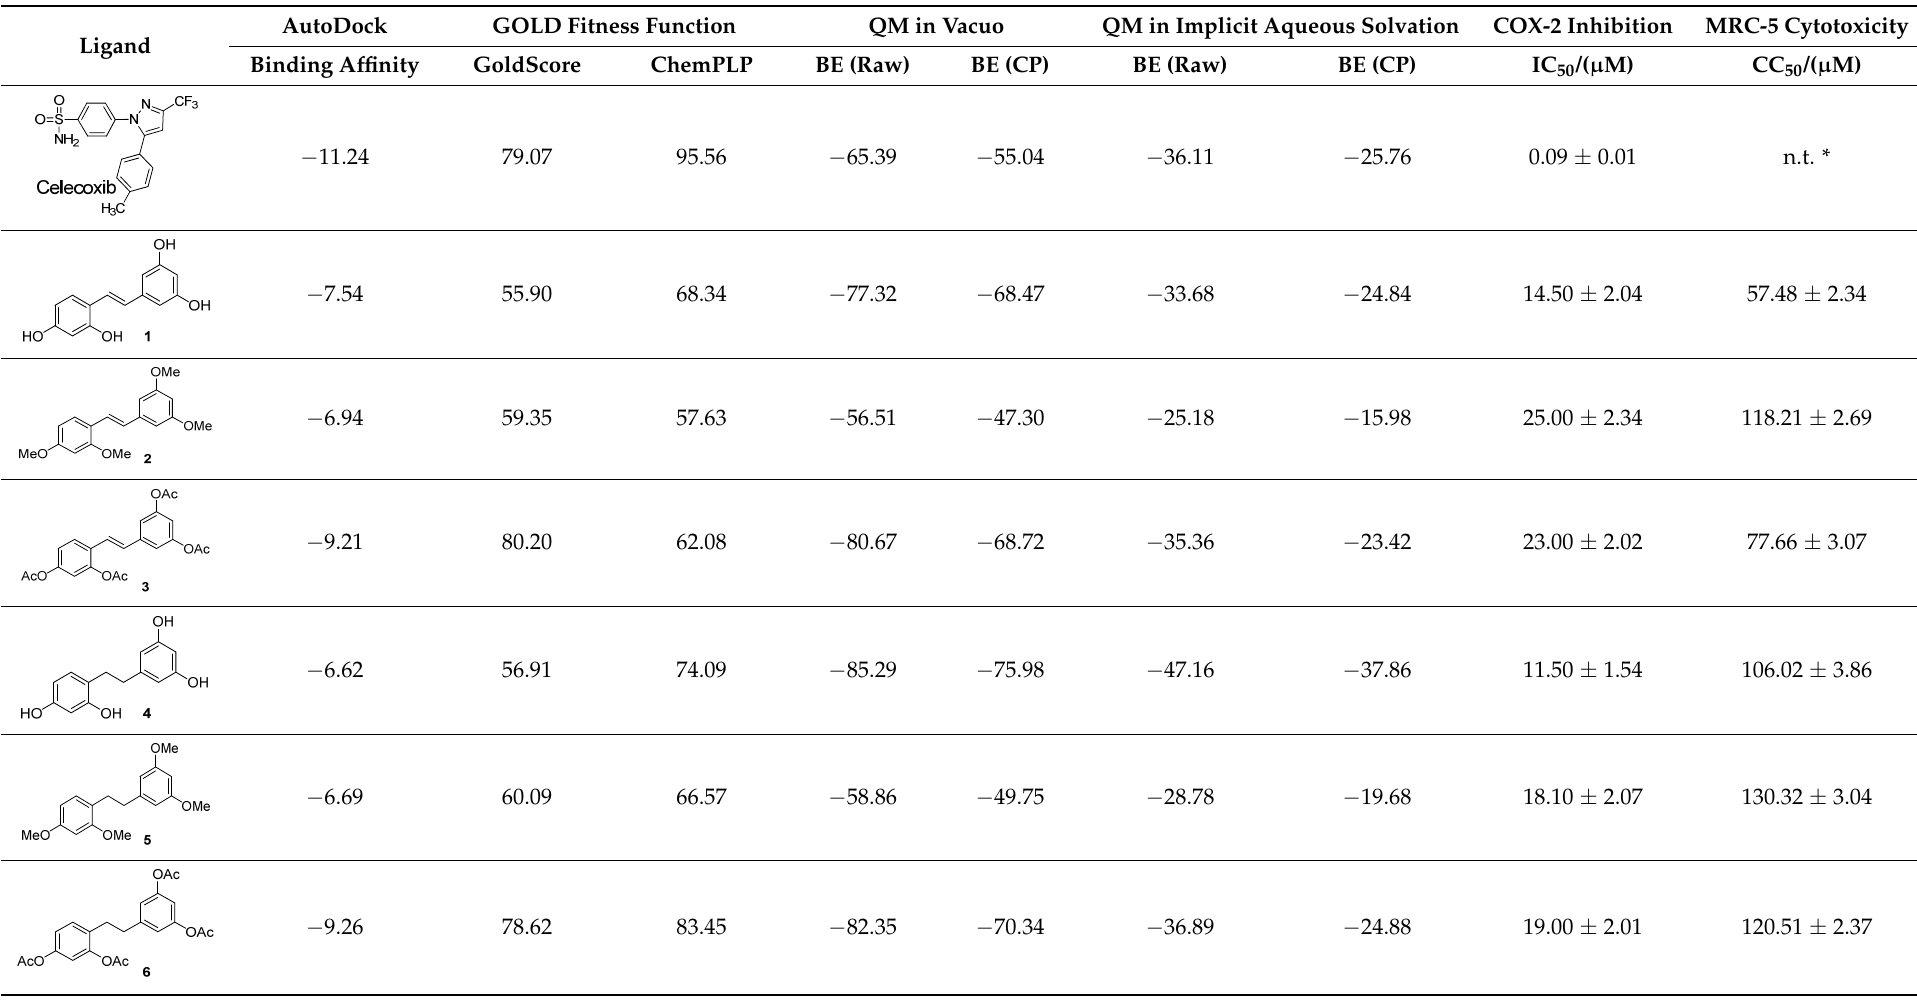
Table 1. Docking scores of the best-docked pose, binding energy (BE) computed at the quantum mechanical (QM) level of the optimized COX-2/ligand complexes and the biological activities. The binding affinity and binding energy are in the unit of kcal/mol.